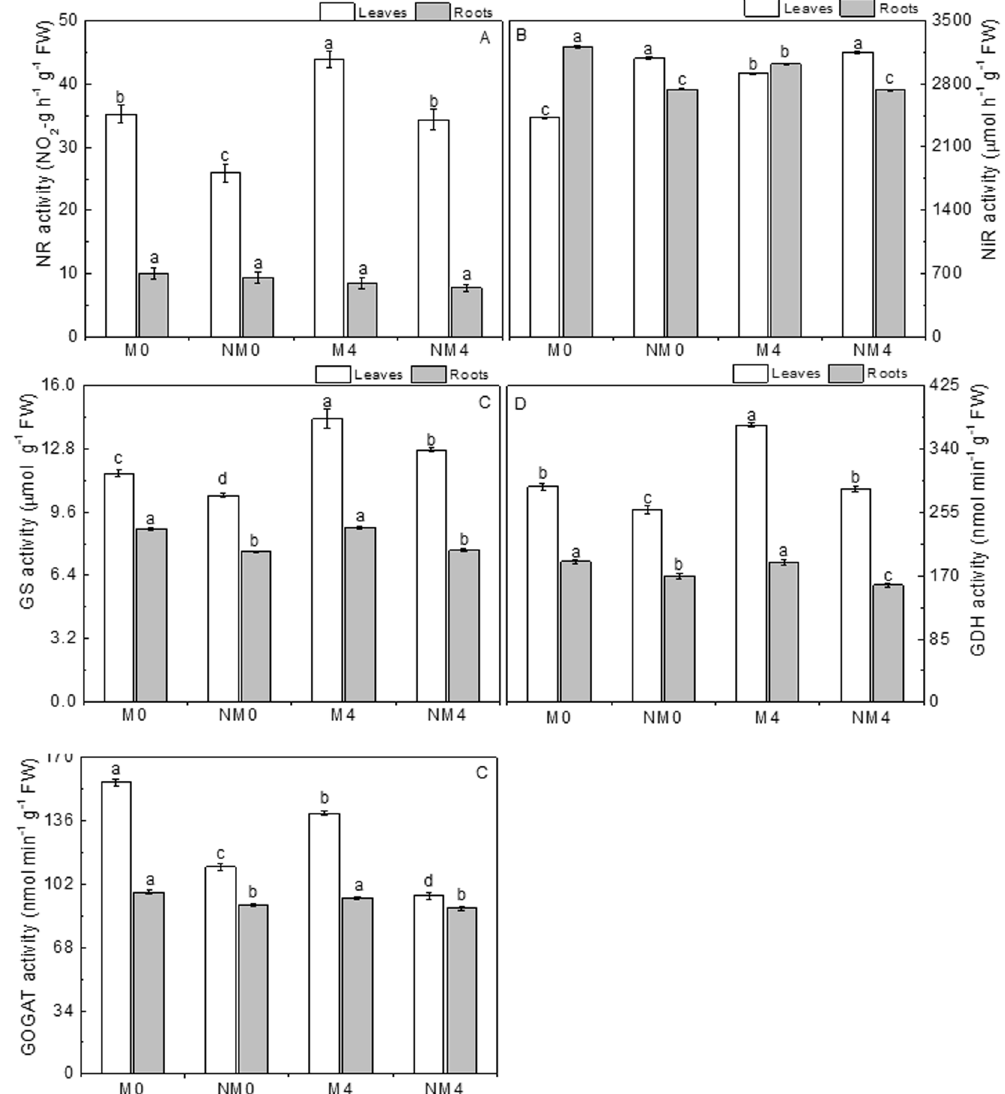
Figure 4. Activity of nitrate reductase (NR, NO 2 - µ g hr − 1 g − 1 FW; A ), nitrite reductase (NiR, μ mol h − 1 g − 1 FW; B ), glutamine synthase (GS, μ mol g − 1 FW; C ), glutamate dehydrogenase (GDH, nmol·min − 1 ·g − 1 FW; D ) and glutamate synthase (GOGAT, nmol·min − 1 ·g − 1 FW; E ) in tender leaves and fine roots after 30 days of irrigation with magnetized and non-magnetized brackish water. The values are the means of three replicates ± SEs. Different lowercase letters show significant differences between means in the same row at the 0.05 probability